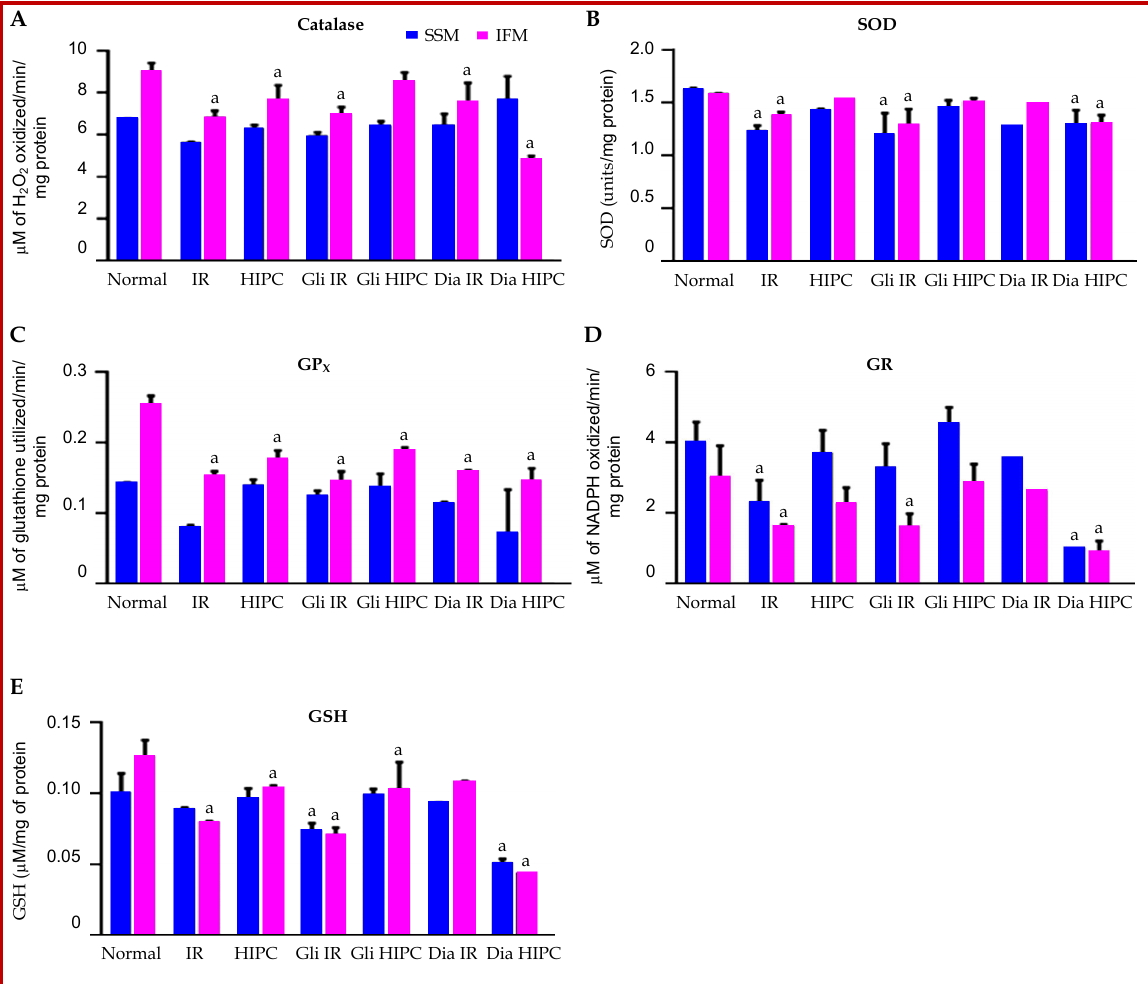
Figure 4: Effect of H 2 S and K ATP modulators on IR induced oxidative stress in cardiac mitochondrial subpopulation: Effect of H 2 S and K ATP modulators on IR induced oxidative stress in cardiac mitochondrial subpopulation were evaluated from the activities of (A) Catalase, (B) Superoxide Dismutase (SOD), (C) Glutathione Peroxidase (GPx) and (D) Glutathione Reductase (GR), (E) Gluta- thione level (GSH). Results are expressed as mean ± SD of n = 6 rats/group. a Statistically significant from normal perfusion